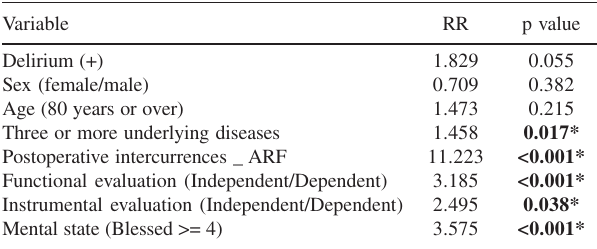
Table 2 - Univariate analysis for